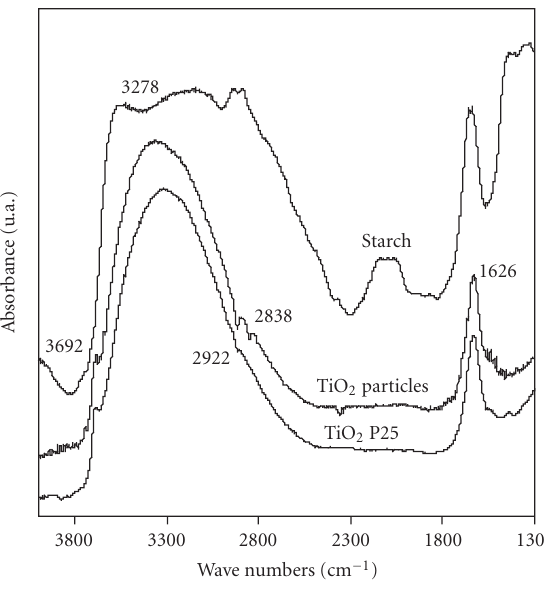
Figure 3: FT-IR spectra of TiO 2 particles aggregates, TiO 2 P25, and starch. The spectra have been displaced vertically for